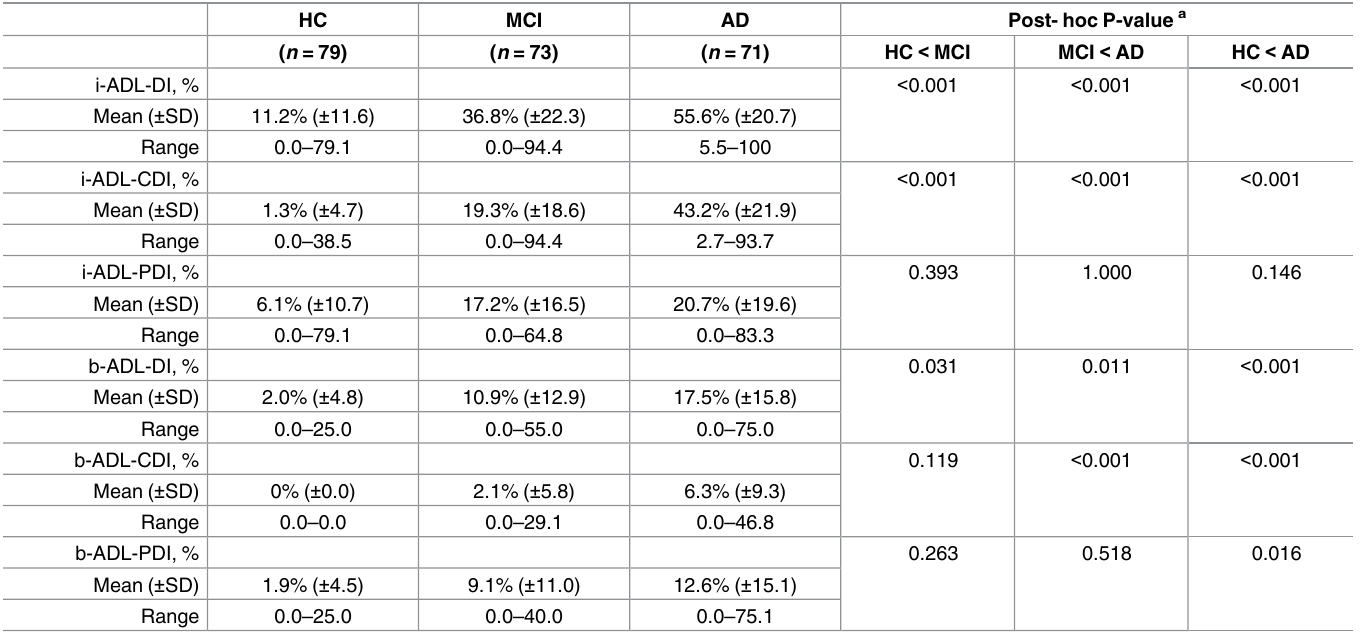
Table 6. Construct validity—Indices of everydayfunctioning in b- and